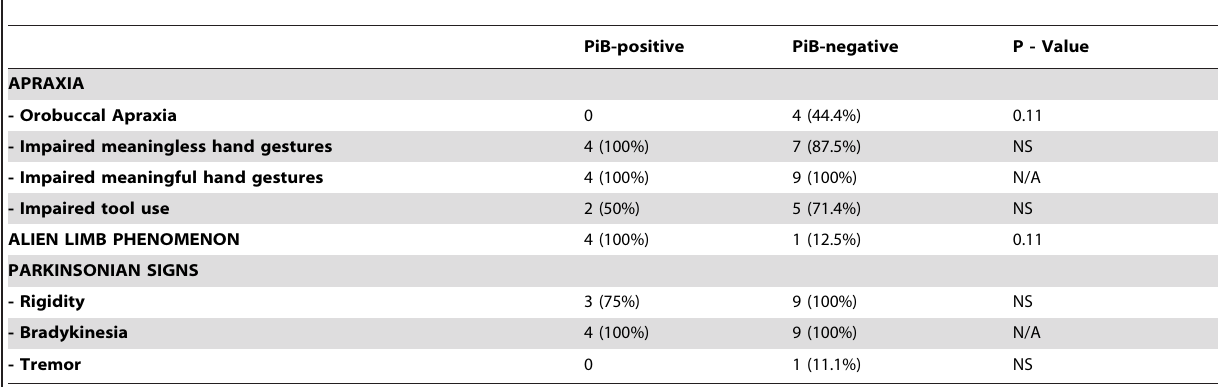
Table 4. Motor features of CBS patients according to PiB